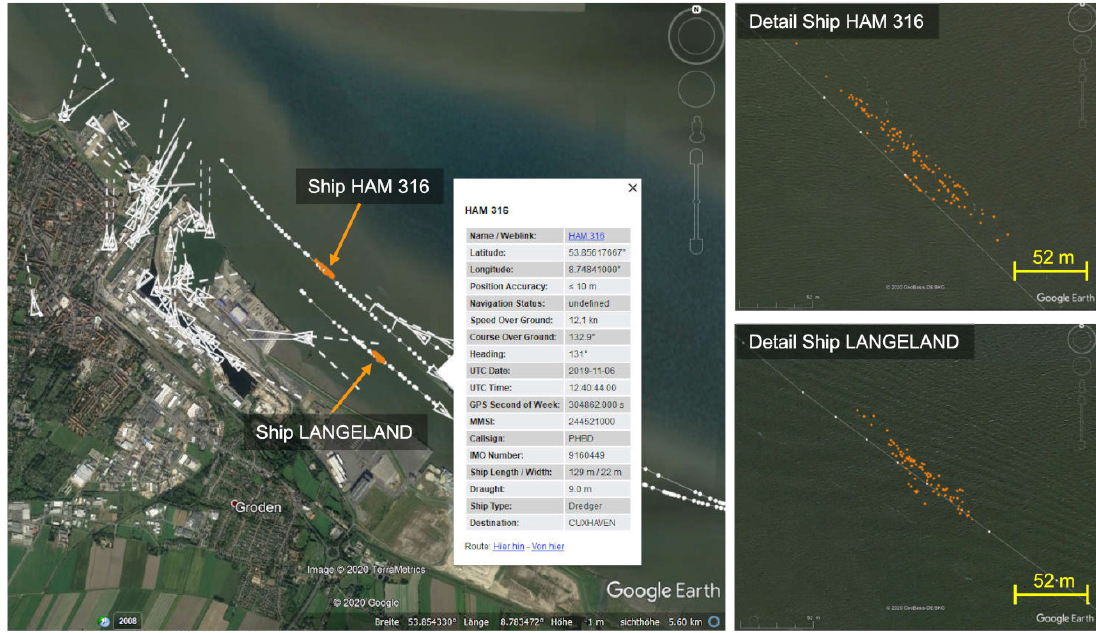
Figure 14. Geocoded radar-based detections of the ships HAM 316 and LANGELAND (orange) and received AIS position messages (white) visualized with Google Earth. Test site: Cuxhaven,